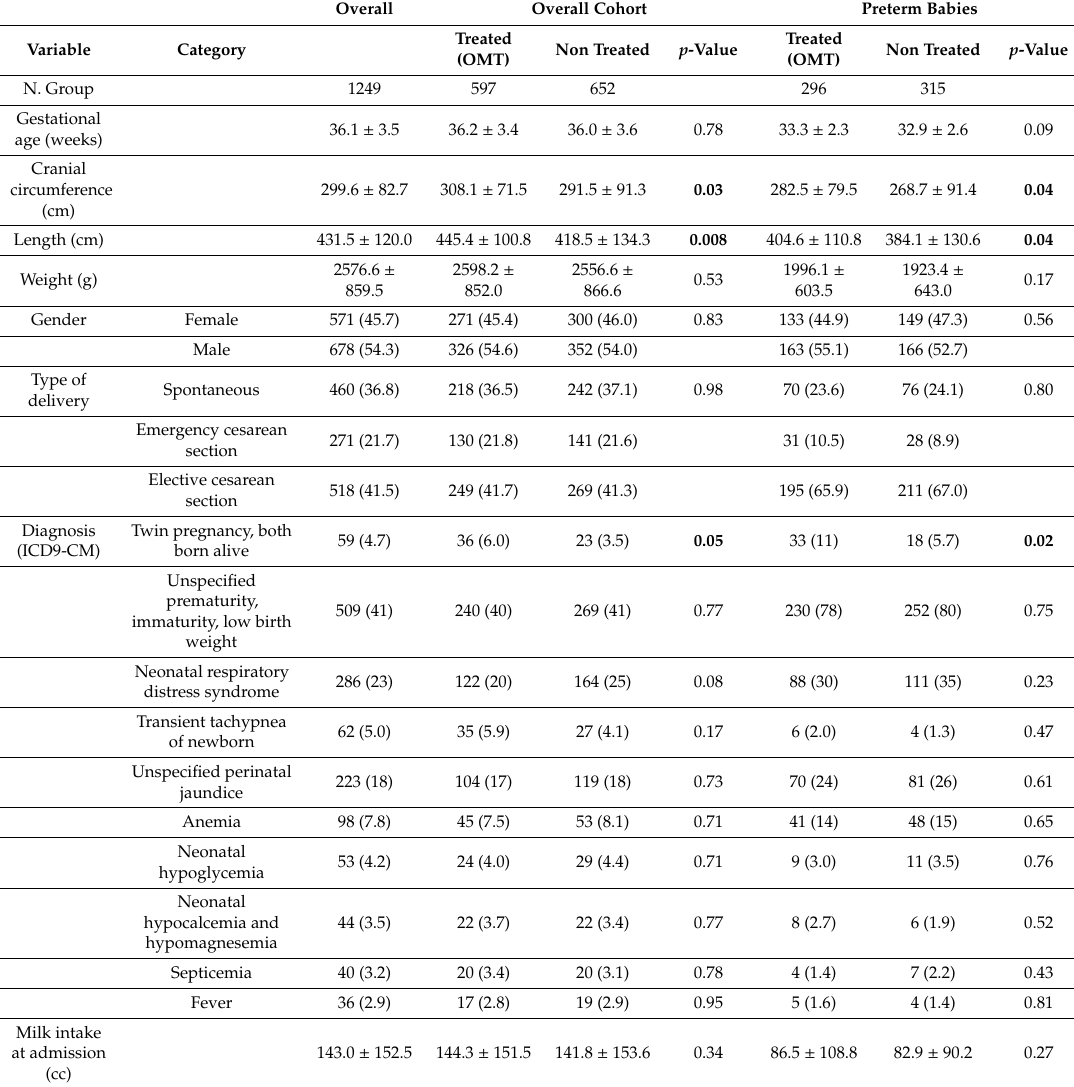
Table 1. Baseline characteristics by treatment (OMT vs. usual care) overall and in preterm babies. Overall Overall Cohort Preterm Babies Treated Non Treated p Variable Category (OMT)